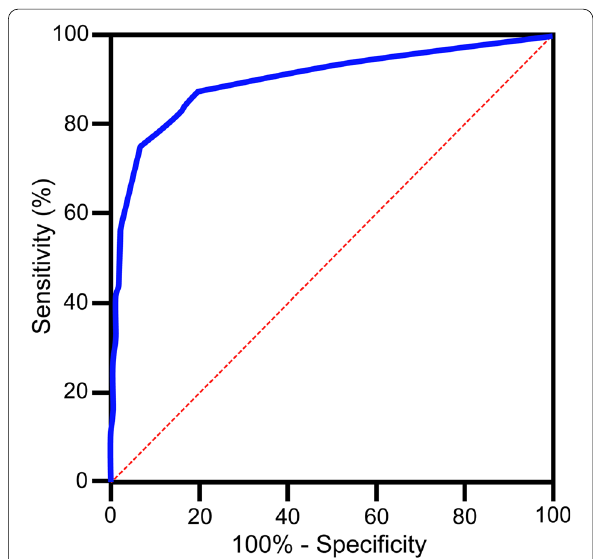
Fig. 5 ROC curve to determine the optimal score for predicting RR-DTC. The AUC was 0.898, and a cutoff value of 10 points was found to be the best for distinguishing between RR-DTC and non-RR-DTC patients. The sensitivity and specificity were 76.0% and 93.0%, respectively. ROC, receiver operating characteristic; RR-DTC, radioiodine refractory differentiated thyroid carcinoma; AUC, area